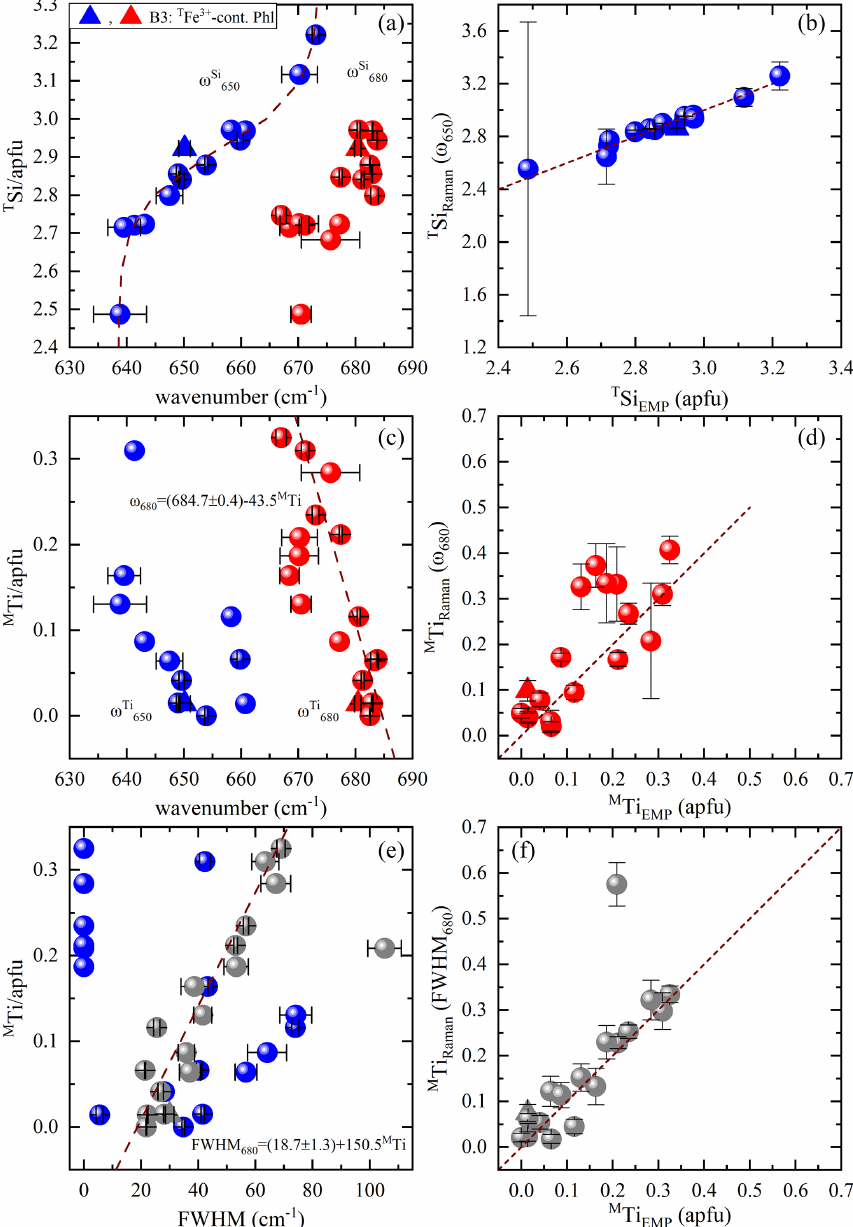
Figure 7. Estimation of T Si and M Ti contents in accordance with the TO 4 -ring modes near 650 and 680cm − 1 : (a) T Si amount vs. Raman peak position at ∼ 650 (blue symbols) and ∼ 680cm − 1 (red symbols), (b) T Si content derived from the Raman spectroscopic analysis ( T Si Raman ) of ω 650 vs. that determined from EMPA ( T Si EMP ), (c) M Ti content vs. Raman peak position at ∼ 650 (blue symbols) and ∼ 680cm − 1 (red symbols), (d) M Ti content obtained from the Raman spectroscopic analysis ( M Ti Raman ) of ω 680 vs. that determined from EMPA ( M Ti EMP ), (e) M Ti amount vs. FWHM at ∼ 650 (blue symbols) and ∼ 680cm − 1 (gray symbols), and (f) M Ti content obtained